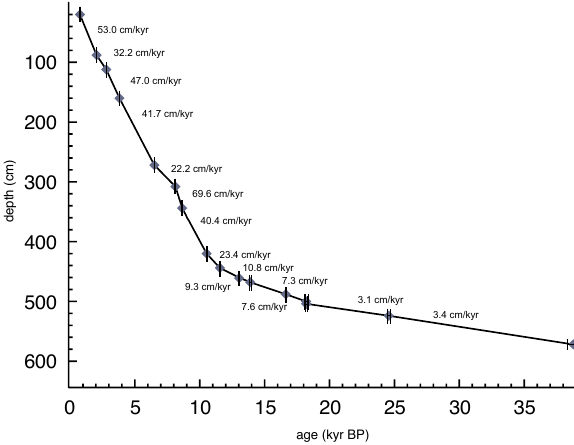
Fig. 2. Age–depth relationship of core GeoB12615-4, including lin- ear sedimentation rates and calibrated radiocarbon ages with error